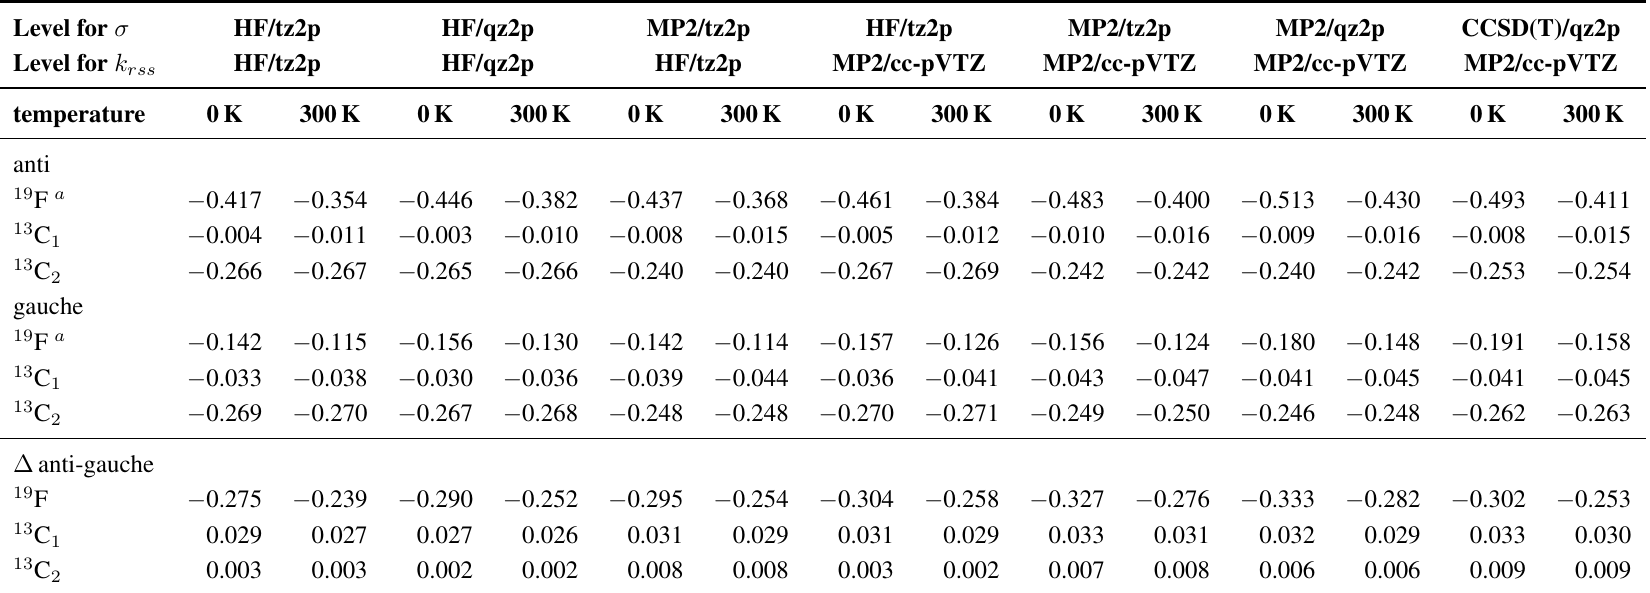
Table 1. Secondary isotope shifts of fluoroethane in ppm with deuterium in gauche and antiperiplanar conformation at different levels of theory for the anharmonic force field k and the chemical shifts σ and for different temperatures. rss Level for